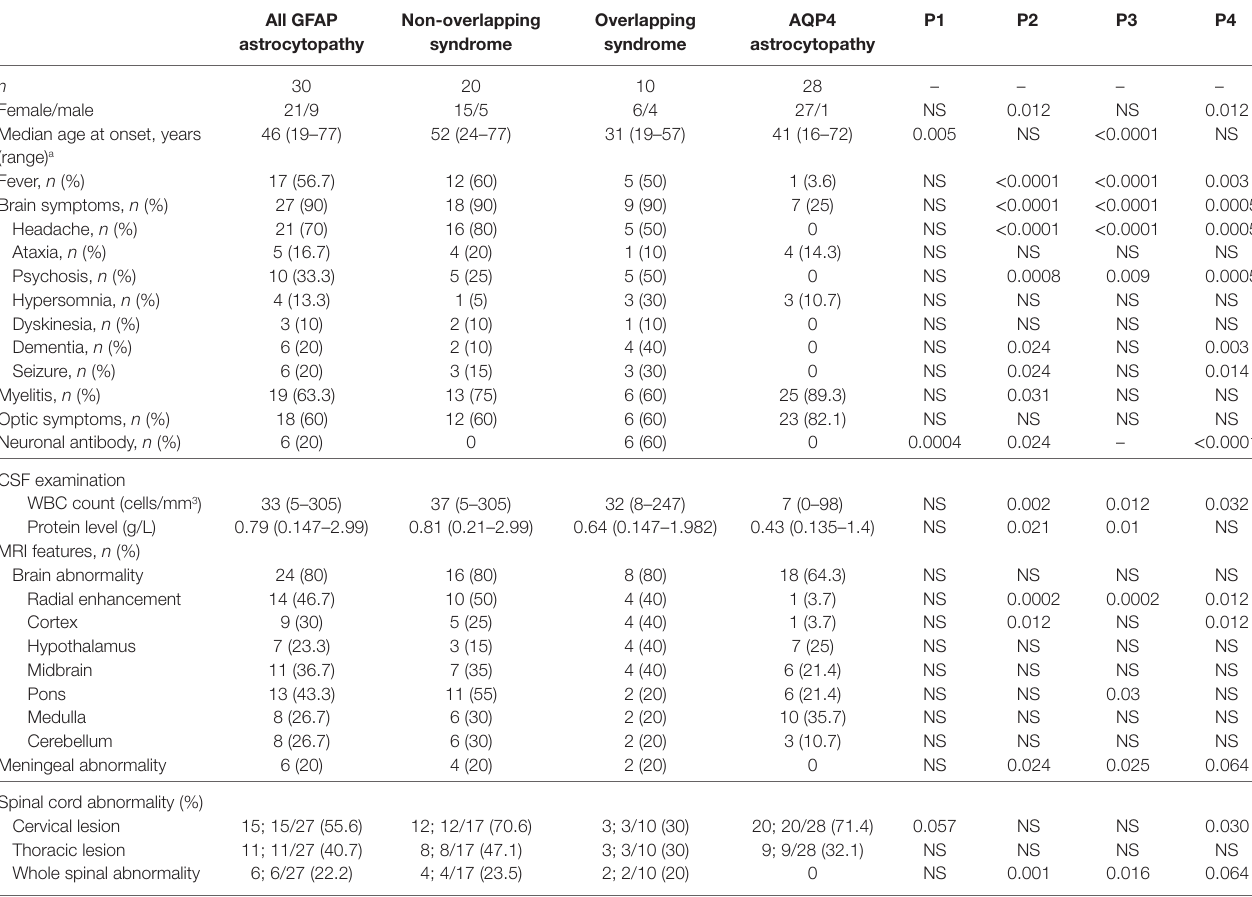
TaBle 2 | A comparison between patients with GFAP and AQP4 astrocytopathy at